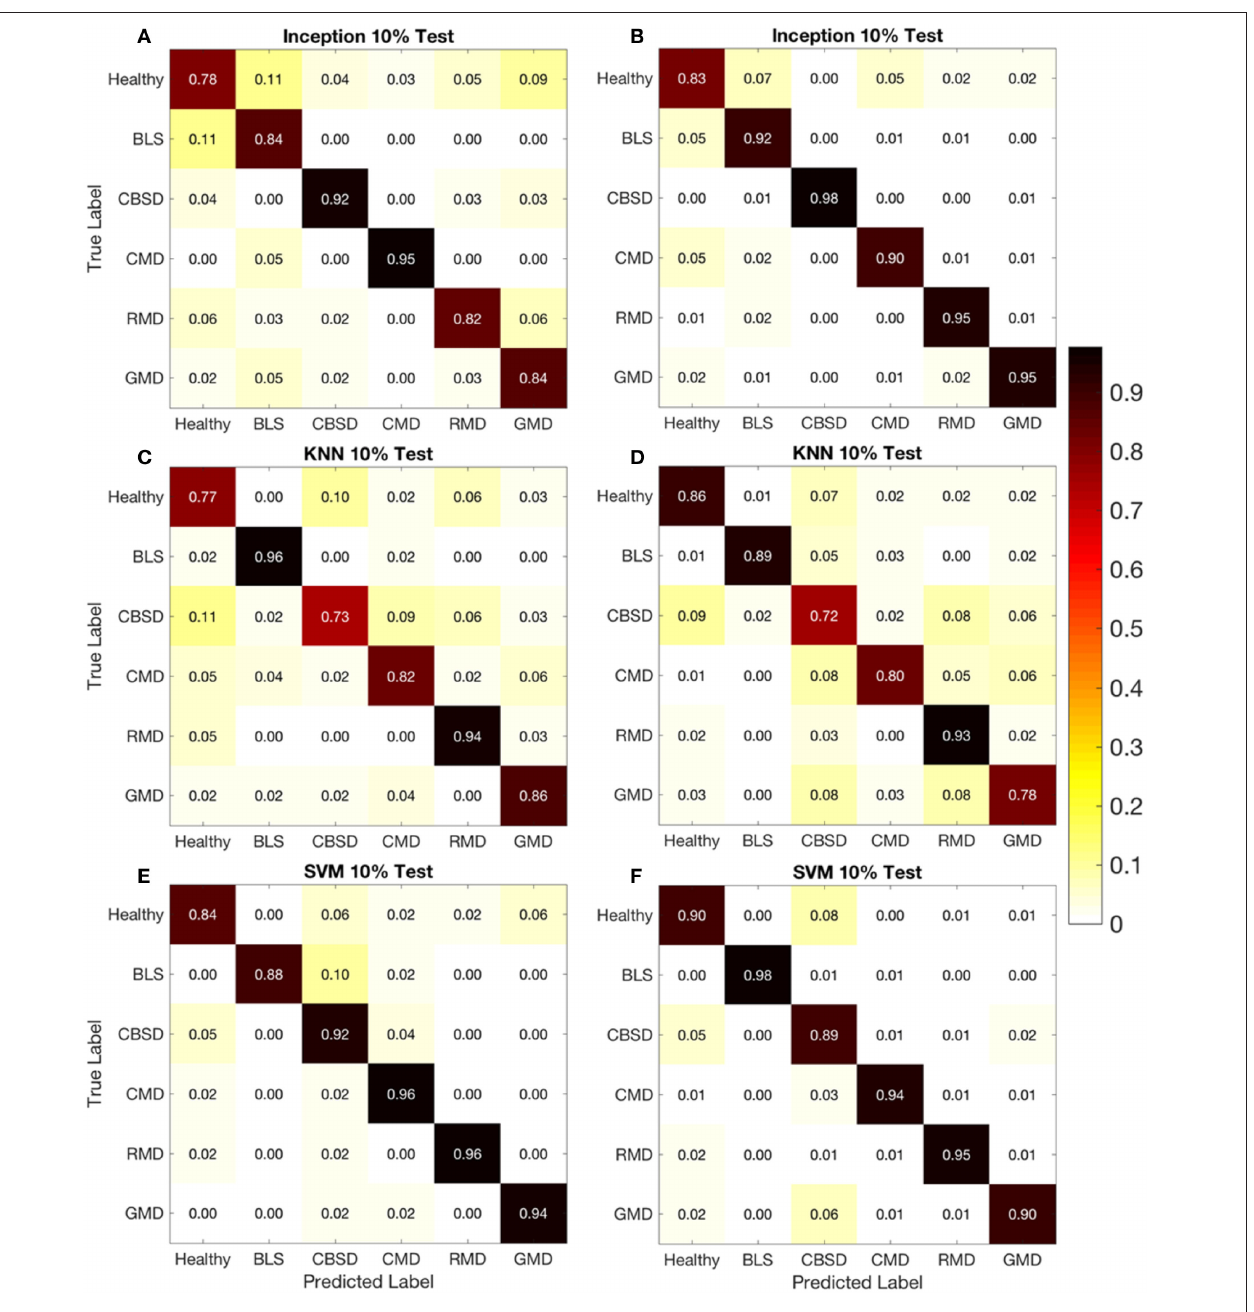
FIGURE 4 | Confusion matrices for 10% test dataset using original (A,C,E) and leaflet (B,D,F)